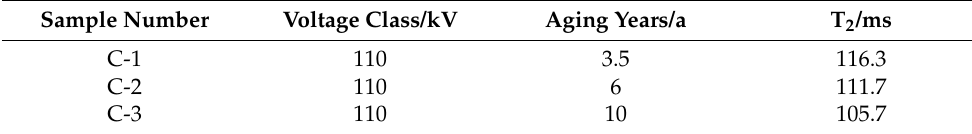
Table 2. Sample’s specific data.